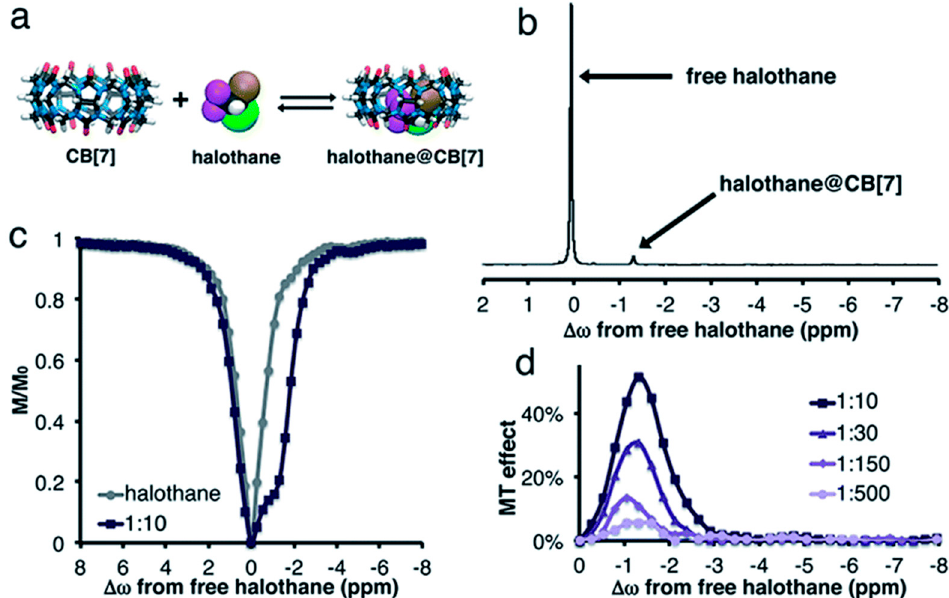
Figure 8. Example of 19 F-GEST spectroscopy with CB[7]. ( a ) Water-soluble halothane forms an inclusion complex with CB[7]. ( b ) The exchange of halothane is much slower compared to Xe•CB[7], as seen by the appearance of a second peak in the direct spectrum. ( c ) Addition of CB[7] to dissolved halothane causes a pronounced saturation transfer response that overlaps with direct saturation of free halothane. ( d ) Even a 50-fold dilution of the CB[7] fraction keeps the supramolecular complex detectable. Reproduced from [58], published by The Royal Society of Chemistry, licensed under a